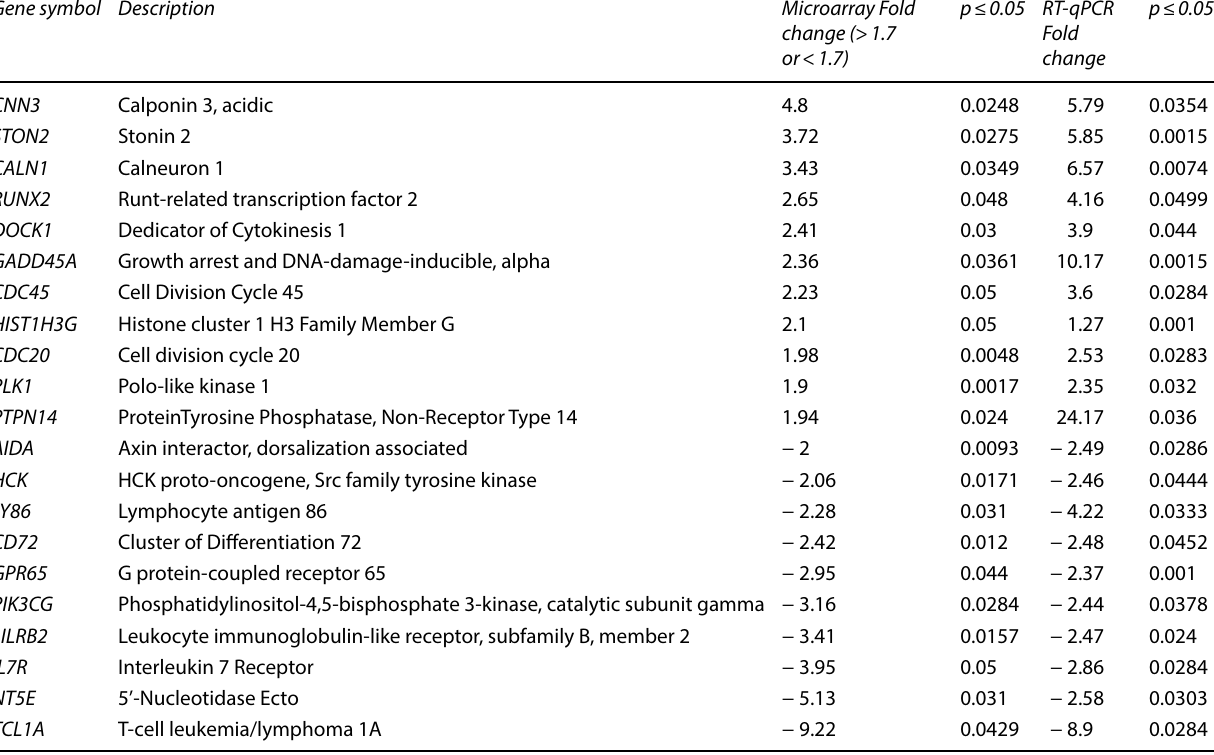
Table 2 Differentially expressed genes (DEG)